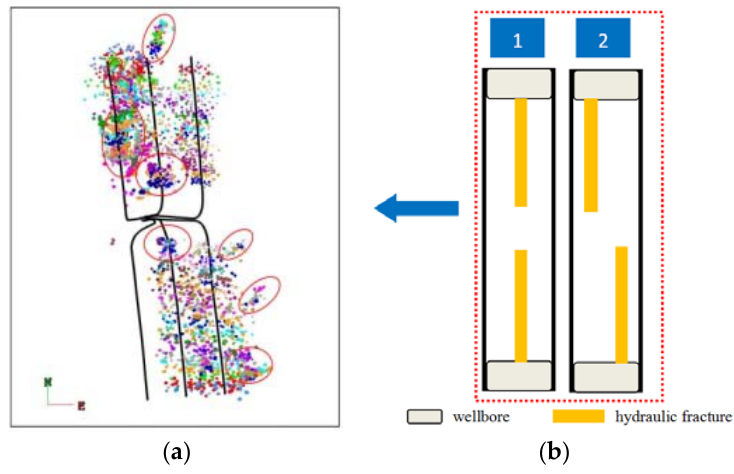
Figure 1. WIPS scheme in tight oil reservoir, ( a ) is one possible scenarios of WIPS scheme; ( b ) is idealizations of two possible illustration of hydraulic fractures.